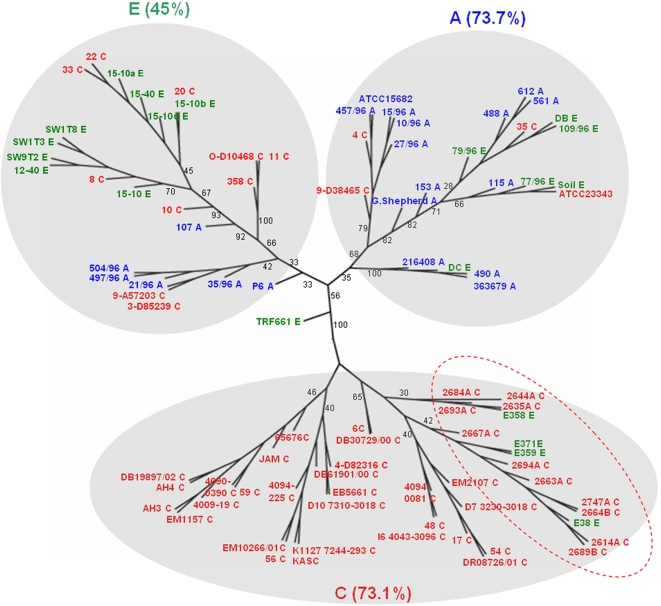
Unsupervised Accessory Genome Clustering of Bp Isolates.Clustering diagram of Bp strains on the basis of accessory genome content. The tree is contructed using MultiExperiment Viewer (MeV) version 4, based on the entire 750-gene accessory genome and combined average linkage hierarchical clustering. Clinical (labeled in red), Animal (labeled in blue) and Environmental (labeled in green) strains are indicated. Isolates from Thailand are highlighted in the red broken circle. Three broad clusters/clades are identified which are named C-clinical, A-animal, E-environmental, with the percentage of concordant strains in that cluster. Numbers on branches represent bootstrap values based on 1000 tests. The bootstrapping analysis reveals a clear distinction between the C (clinical) and A/E clusters (non-clinical - animal and environmental) (Bootstrap value = 100).